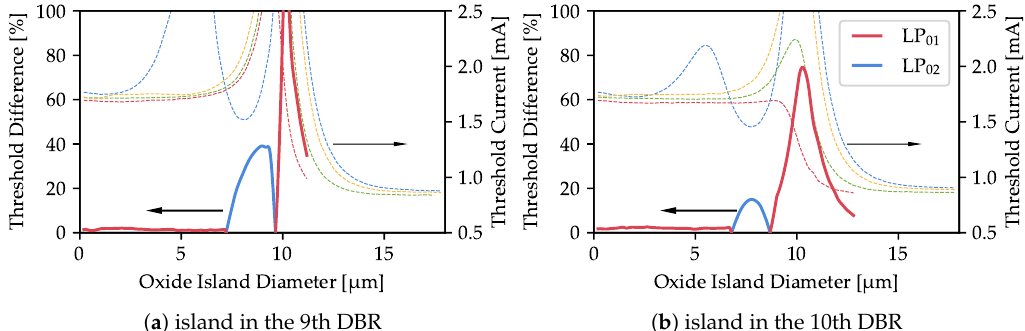
Figure 9. Threshold current differences between the mode with the lowest threshold and that with the next lowest threshold current. The line colors indicate the lowest-threshold